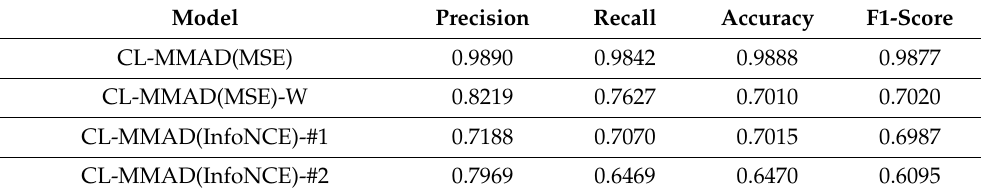
Table 5. Performance evaluations of CL-MMAD.